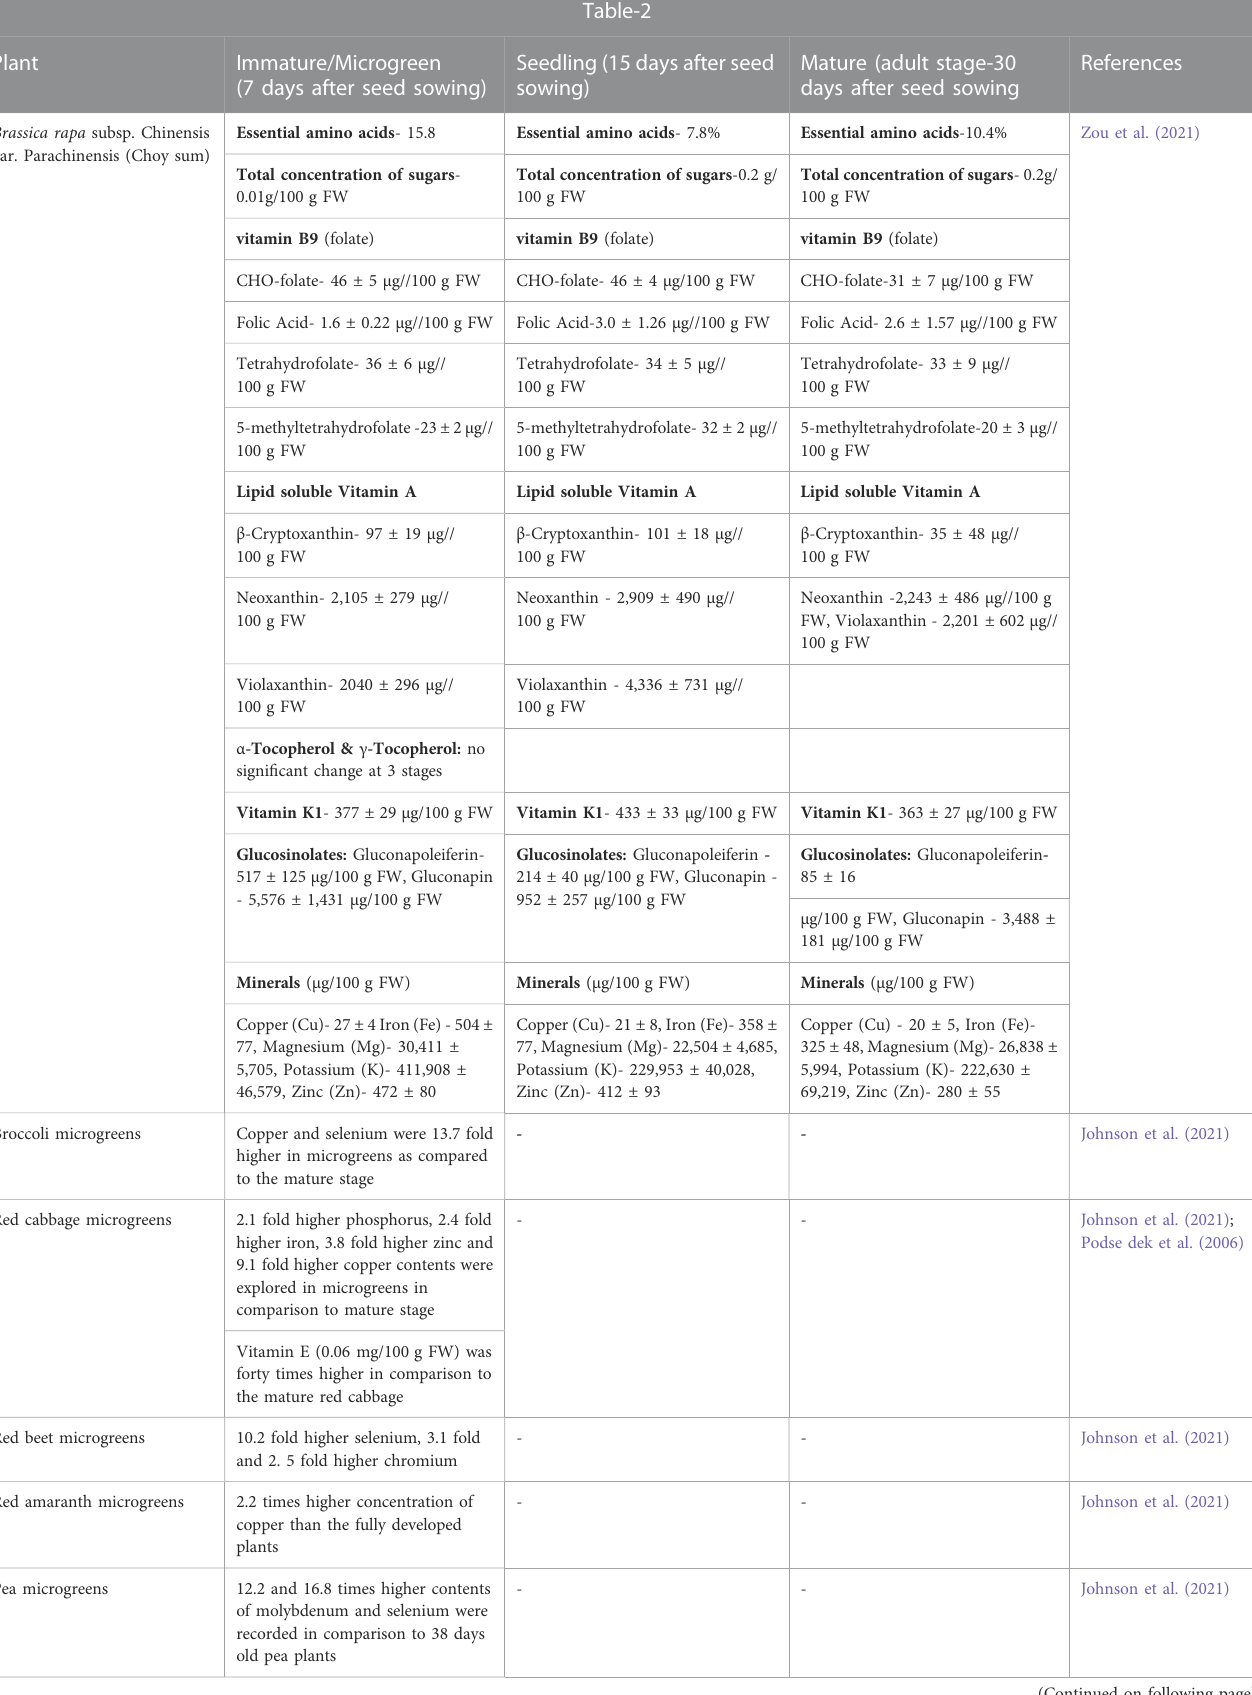
TABLE 2 Comparative analysis of nutritional components in microgreeens, mature part and different stages of plants.